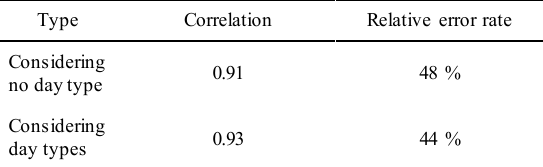
Table 5. Correlation and Relative Error Rate